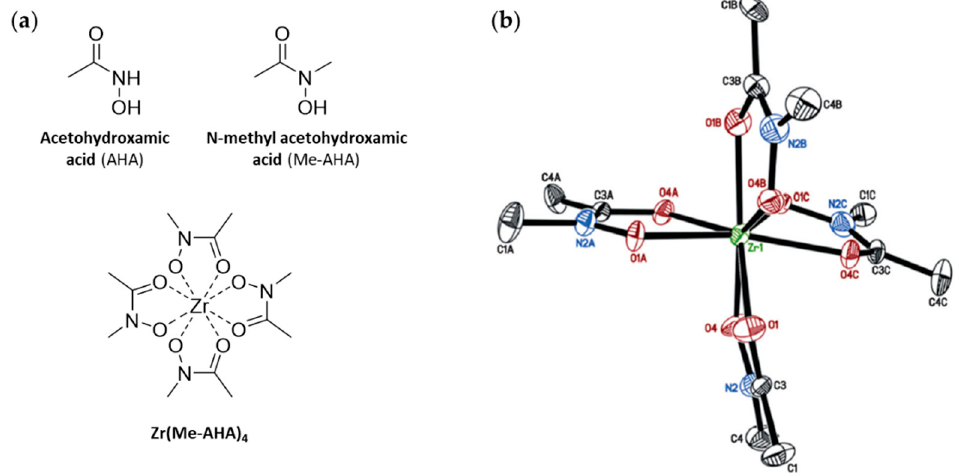
Figure 7. ( a ) Chemical structures of AHA, Me-AHA and Zr(Me-AHA) 4 . ( b ) X-ray structure of Zr(Me-AHA) 4 obtained from the 0.572 × 0.258 × 0.097 mm 3 crystal. Displacement ellipsoids are shown at the 50% level, hydrogen atoms and water molecules have been omitted for clarity. Reproduced from [68] with permission from The Royal Society of Chemistry